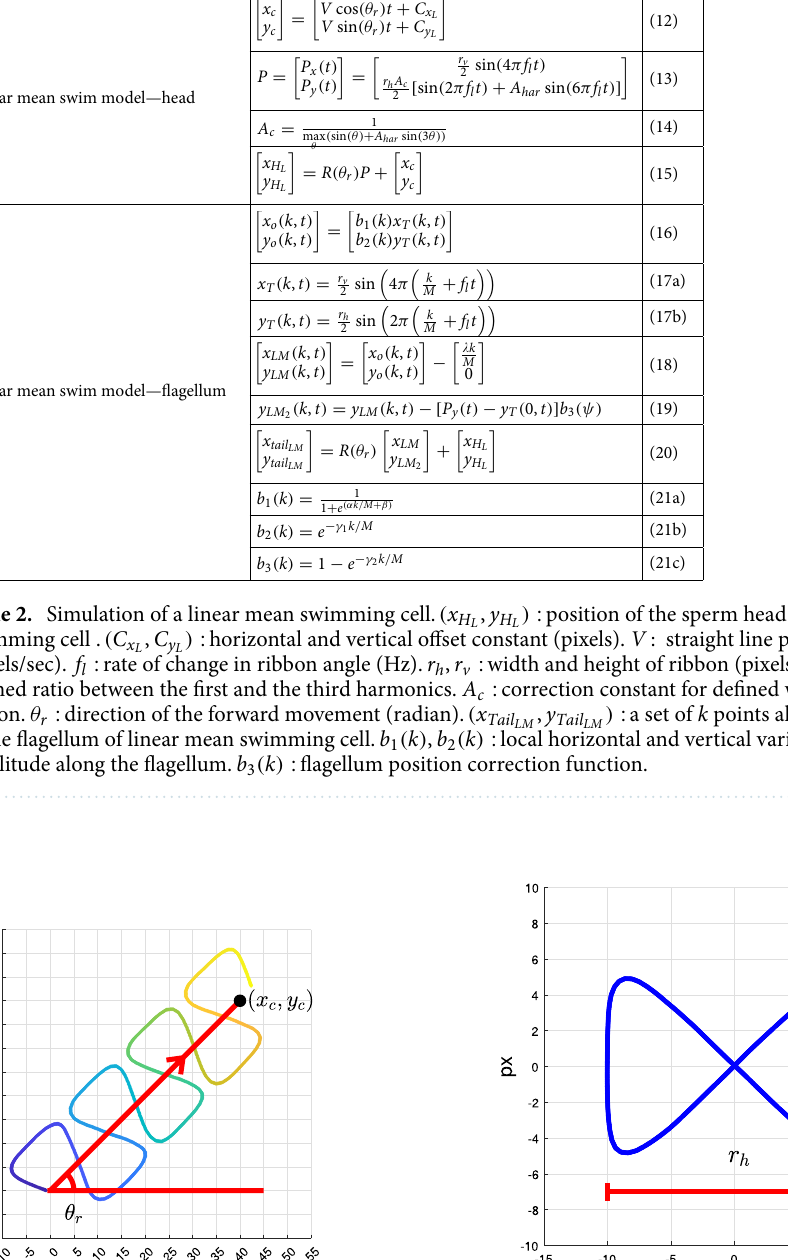
Linear mean swim model. In linear mean swim, a sperm cell moves along a straight-line path, rolling side to side as it propels itself forward. This feature causes a ribbon-like movement about the straight line. The equations used to model the movement of the head and the flagellum of linear mean swimming cell are given in Table 2. We generate the cell head movement (ribbon-like movement along a linear path) using Eqs. (12–15). The position along the linear path is denoted ( x c , y c ) and the position along the ribbon-like movement is denoted ( P x ( t ) , P y ( t ) ). The resulting path is shown in Fig. 14a. , C The straight-line path is a linear function of time t with initial positions of ( C x y L ) . The straight-line path is L , y , C a line segment from initial positions ( C x c ) (as shown in Fig. 14). The horizontal and verti- y L ) to the point ( x c L cal positions along the linear path ( x c , y c ) change at the rate of horizontal and vertical velocity in the direction